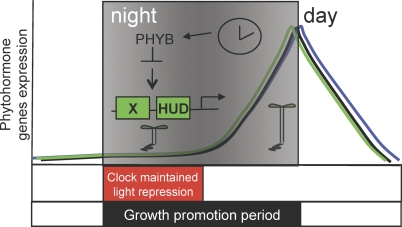
Model Describing Circadian-, Light-, and Phytohormone-Mediated Hypocotyl GrowthThe circadian clock and light signaling interact to coordinate a group of different phytohormone transcripts (represented by green, blue, and black lines) to coincide with the dark-to-light transition at dawn. Hypocotyl elongation is a mode of dark growth, so the dark phase of each day is the “growth promotion” period (black box). The circadian clock ensures that growth does not proceed immediately upon exposure to darkness by gating light signaling during the “circadian-maintained light repression” period (red box). The circadian clock maintains light repression during the early evening through light signaling and PHYB activity. In turn, PHYB activity acts indirectly through an unknown gene on at least two cis-acting elements, the HUD and an unknown X element, to repress phytohormone transcript abundance. As night proceeds, circadian maintenance of light signaling decreases, repression of phytohormone transcript abundance is released, and maximal growth occurs at dawn [15,17]. This model does not attempt to describe hormone abundance or activity. It specifically describes the coordination of phytohormone gene transcript abundance by the circadian clock and light signaling to coincide with the hypocotyl growth window. However, the predictive nature of this model provides a framework for future studies that will directly interrogate the specific interactions of hormones in controlling growth.